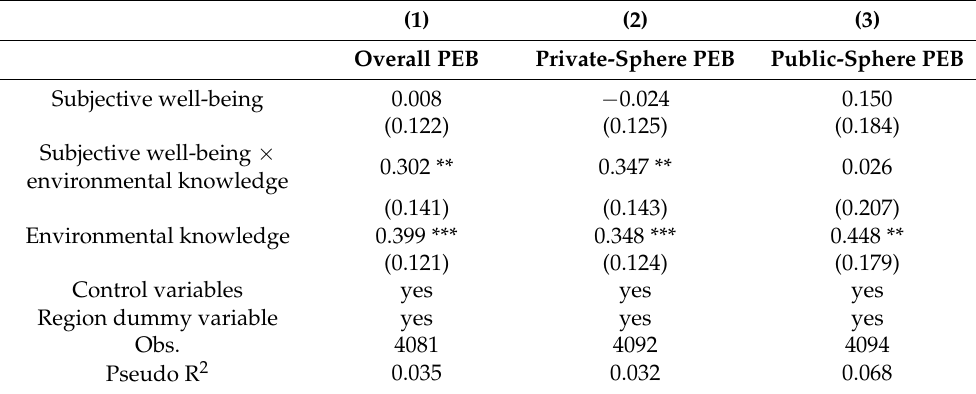
Table 7. The influence of subjective well-being on the PEB of rural residents: the moderating role of environmental knowledge.